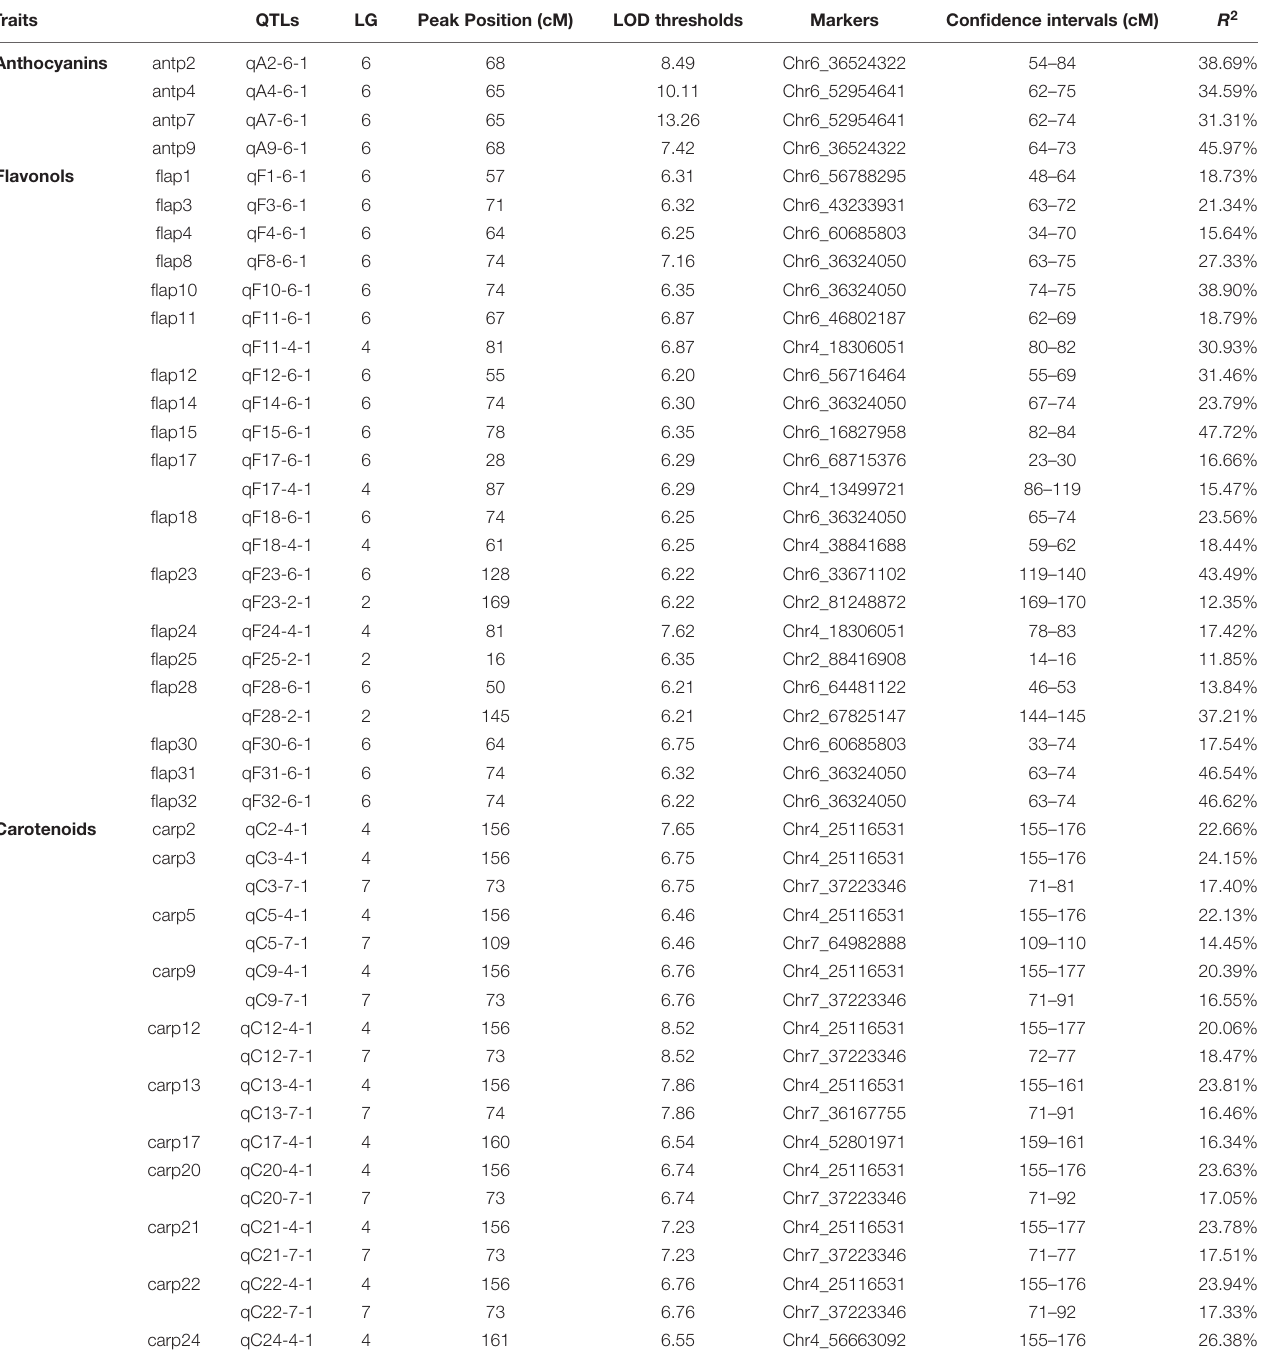
TABLE 5 | Summary of QTLs for pigment content traits detected in the YS